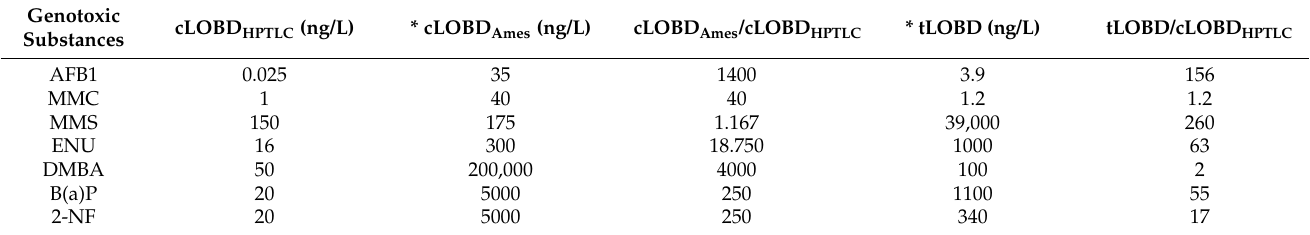
Table 4. Comparison of the calculated LOBDs for theHPTLC − S9-Umu-C versus the standard Ames bioassays for selected genotoxic